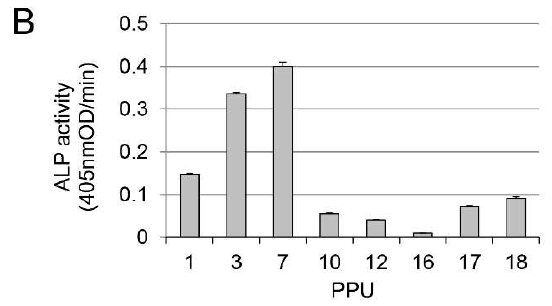
Figure A1. Morphology and inherent alkaline phosphatase (ALP) activity of porcine dental pulp-derived cell lines. ( A ) Eight dental pulp-derived cell lines (PPU-1, -3, -7, -10, -12, -16, -17, and -18) are shown. Bars = 50 μm. ( B ) Inherent ALP activity of the respective cell lines. Data bars are means ± standard error (SEM) of 6 culture wells.